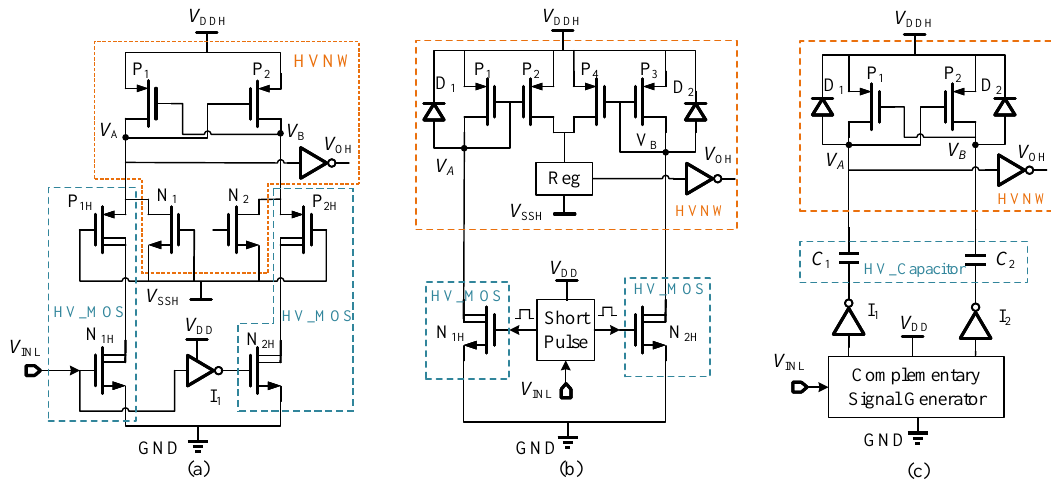
Figure 1. Three topologies of FHV-LS: ( a ) DC-LS, ( b ) CM-LS, ( c )